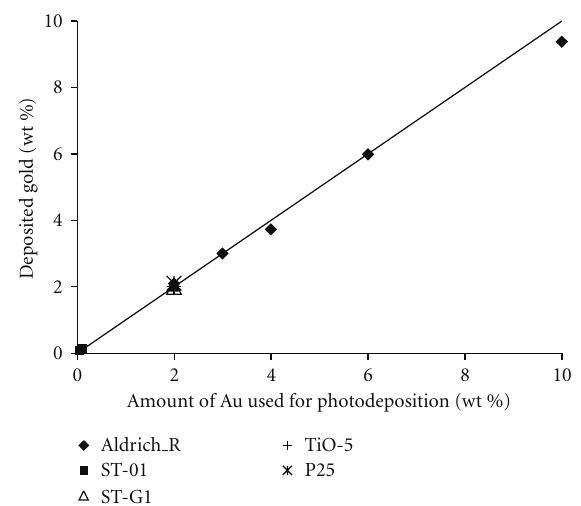
Figure 5: Correlation between gold amounts used for photodepo- sition and determined in Au/TiO 2 samples by